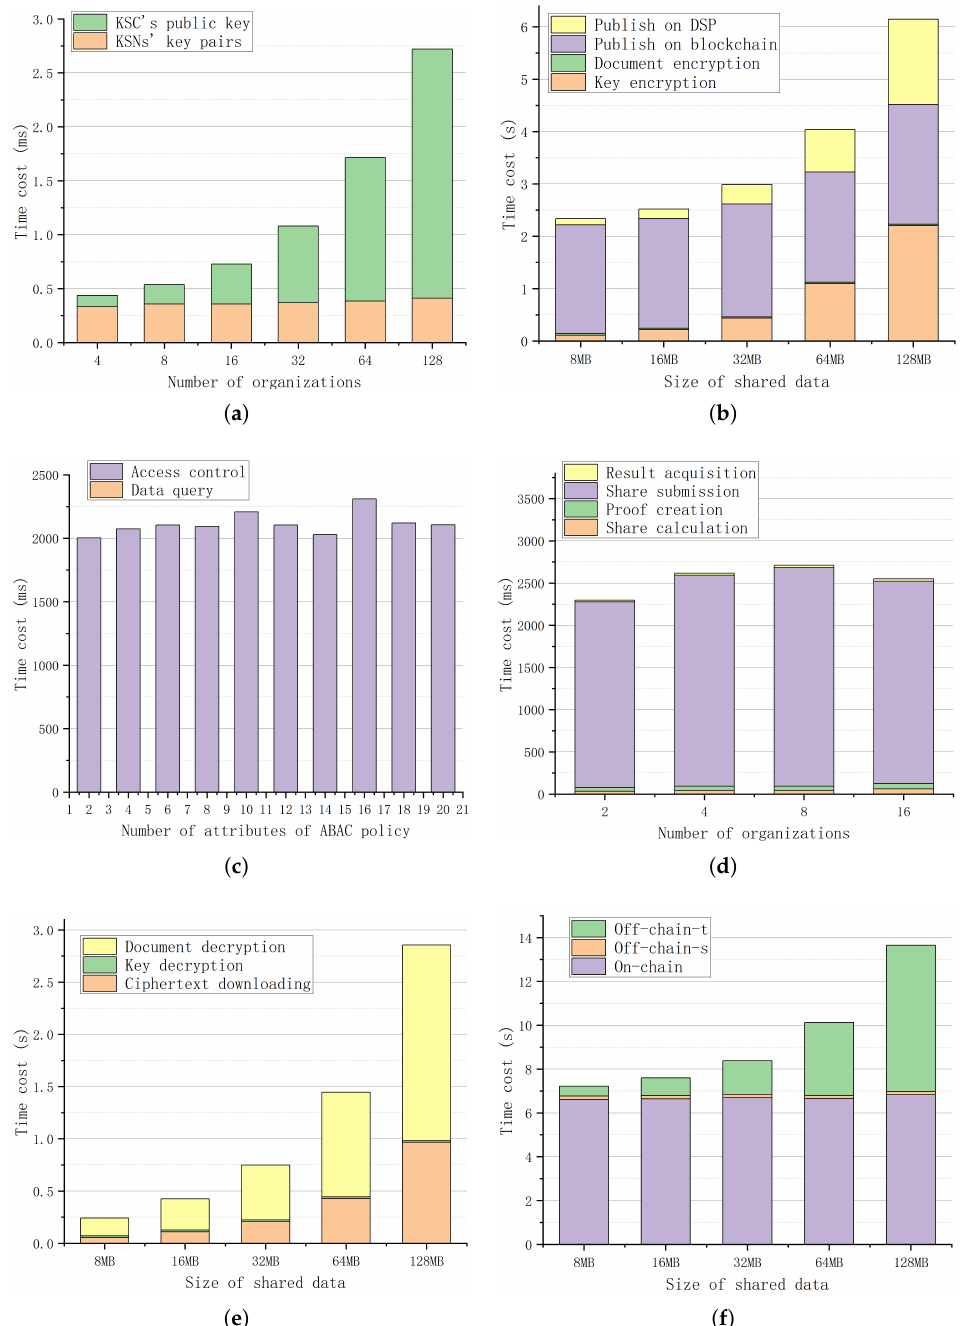
Figure 5. Performance evaluation results of the proposed system. ( a ) The key generation time under different settings of organization numbers; ( b ) The time cost of the data upload phase under different settings of data sizes; ( c ) The time cost of the data query phase under different settings of attribute numbers; ( d ) The time cost of the VPKS protocol under different settings of organization numbers; ( e ) The time cost of the ciphertext acquisition and decryption under different settings of data sizes; ( f ) The time cost of different operation categories under different settings of data